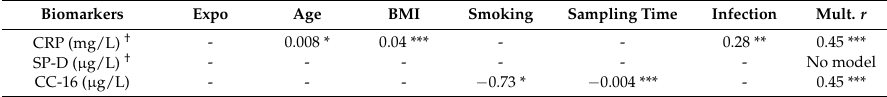
Table 4. Statistically significant results from multiple linear regression analysis (backward procedure). Dependent variables were the concentrations of C-reactive protein (CRP), club cell protein 16 (CC-16)